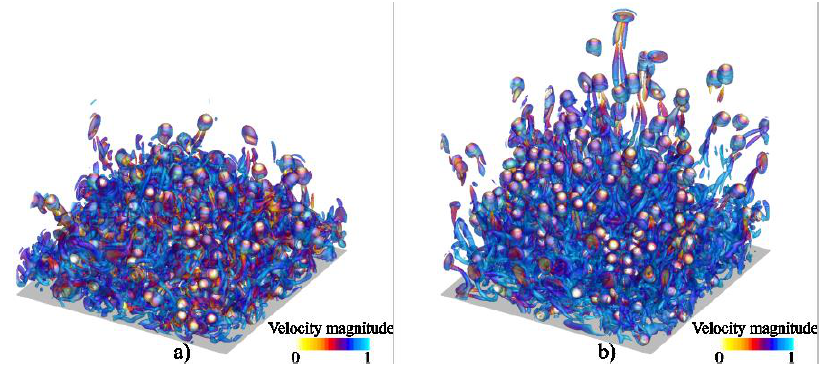
Figure 21. Instantaneous distribution of second invariant of velocity tensors ( Q = 0.1) for scheme B500: ( a ) t * = 40, ( b ) t * = 50. The color of the isosurface represents the magnitude of the velocity.